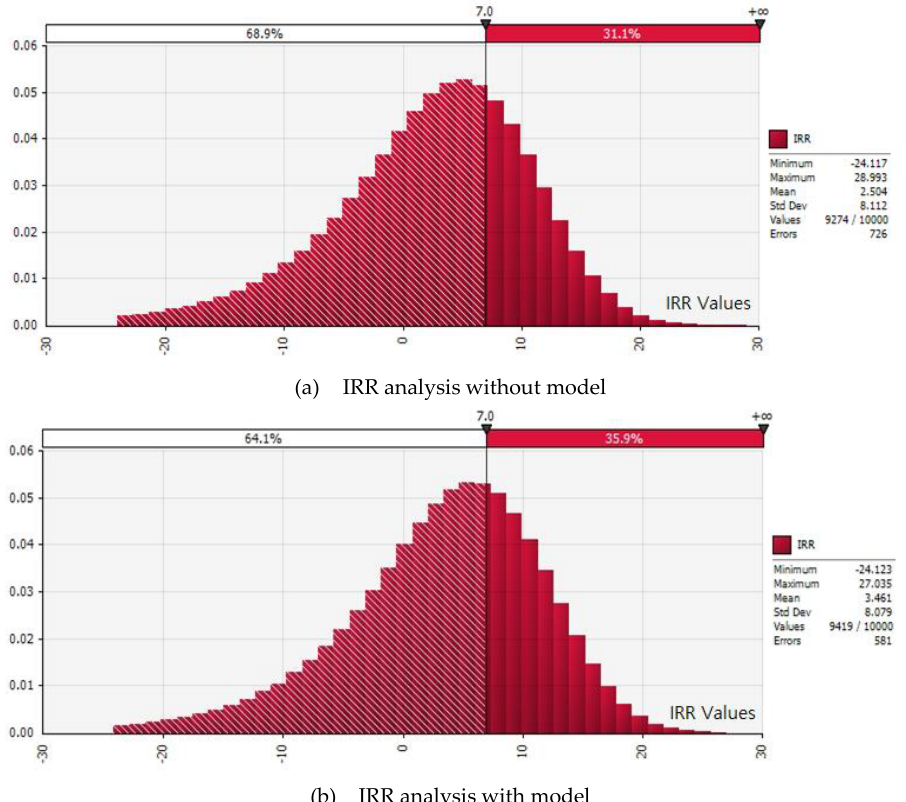
Applied Sciences 2018 , 11 , x FOR PEER REVIEW Figure 8. NPV probabilistic analysis (a) without model and (b) with model Figure 8. NPV probabilistic analysis ( a ) without model and ( b ) with model.